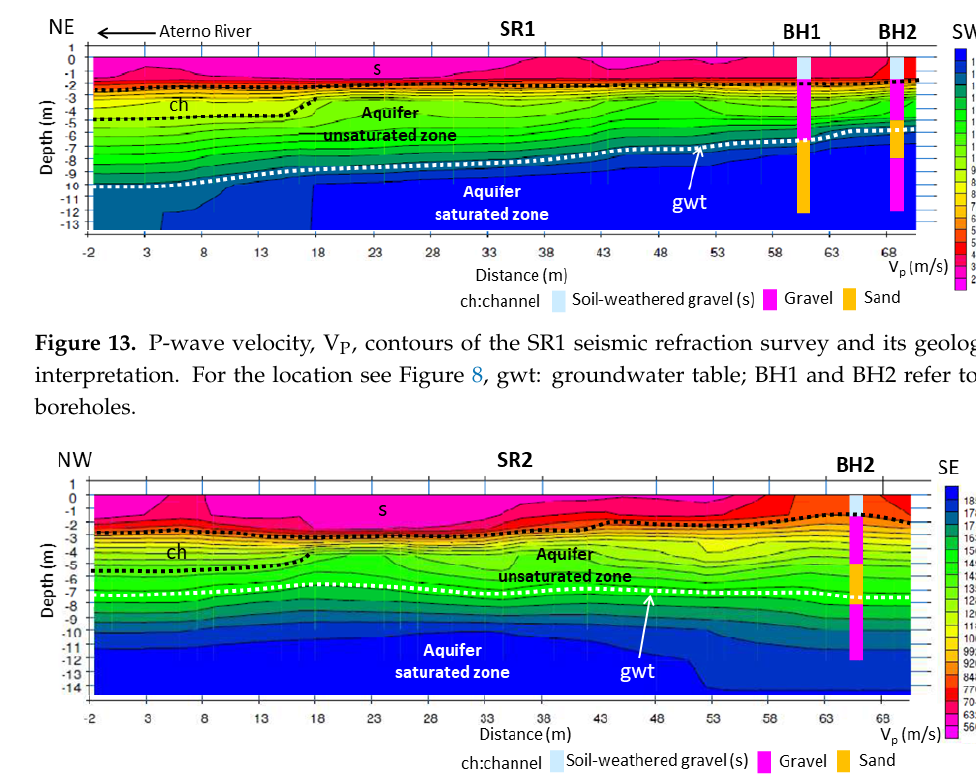
Figure 14. P-wave velocity, V P , contours of the SR2 seismic refraction survey and its geological interpretation. For the location see Figure 8. gwt: groundwater table; BH2 refers to the borehole.